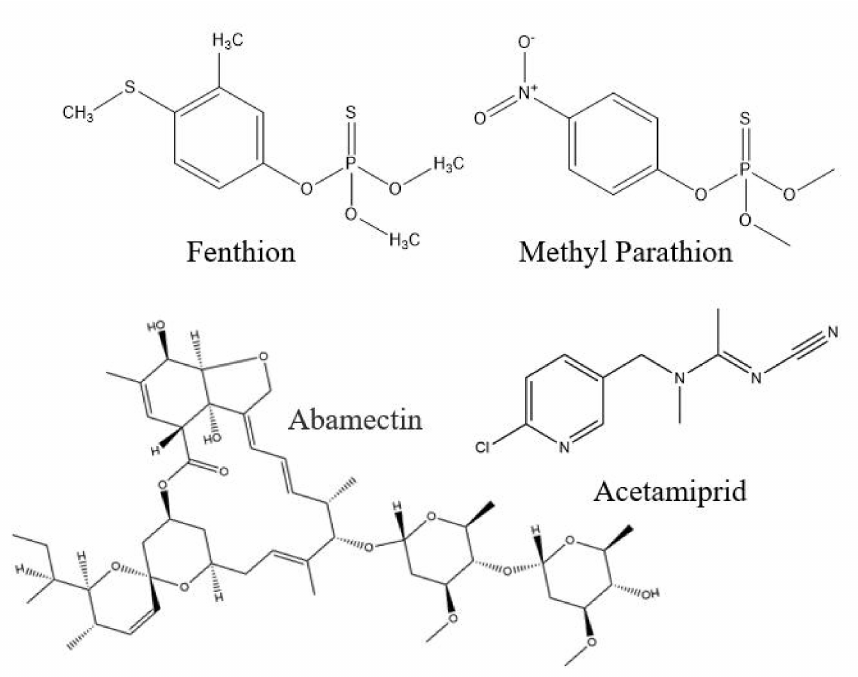
Figure 1. Chemical structure of fenthion, methyl parathion, abamectin and acetamiprid. In response to regular pesticide application in agriculture, new, rapid analytical meth- ods are required for pesticide detection with easy application, low costs and reliability